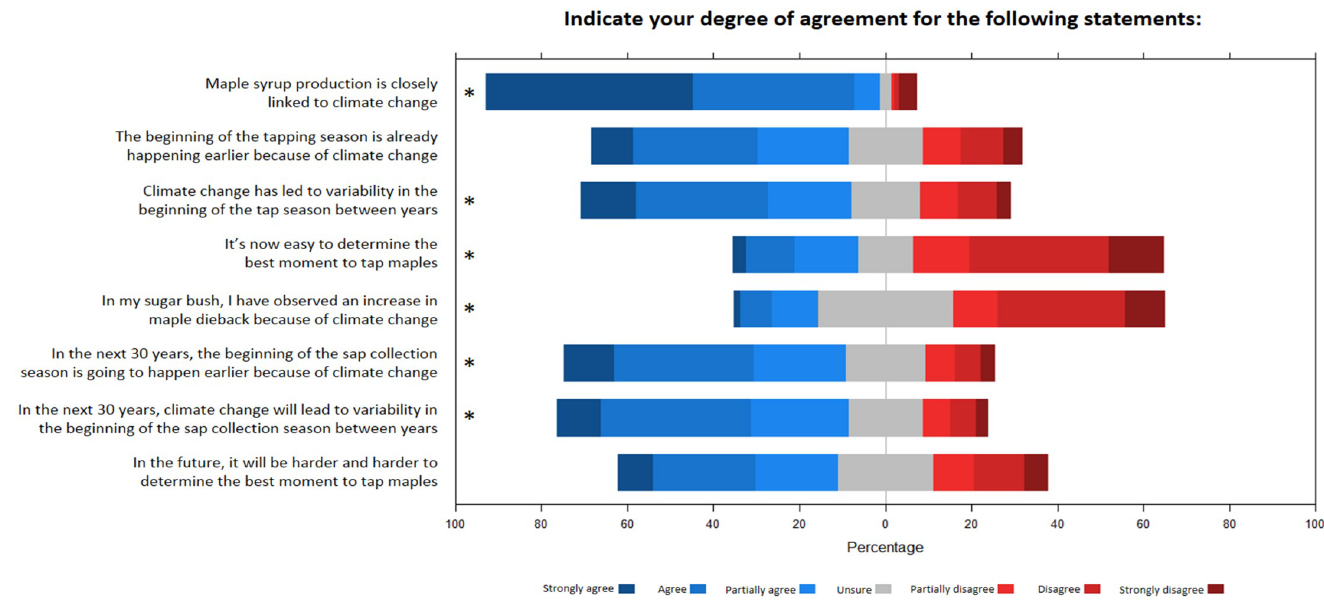
Fig 7. Climate change and maple syrup production. Responses of the survey participants for statements about climate change impacts on maple syrup production. Statements followed by a � symbol indicate a significant effect of at least one predictor (see Table 3 and S3 File).